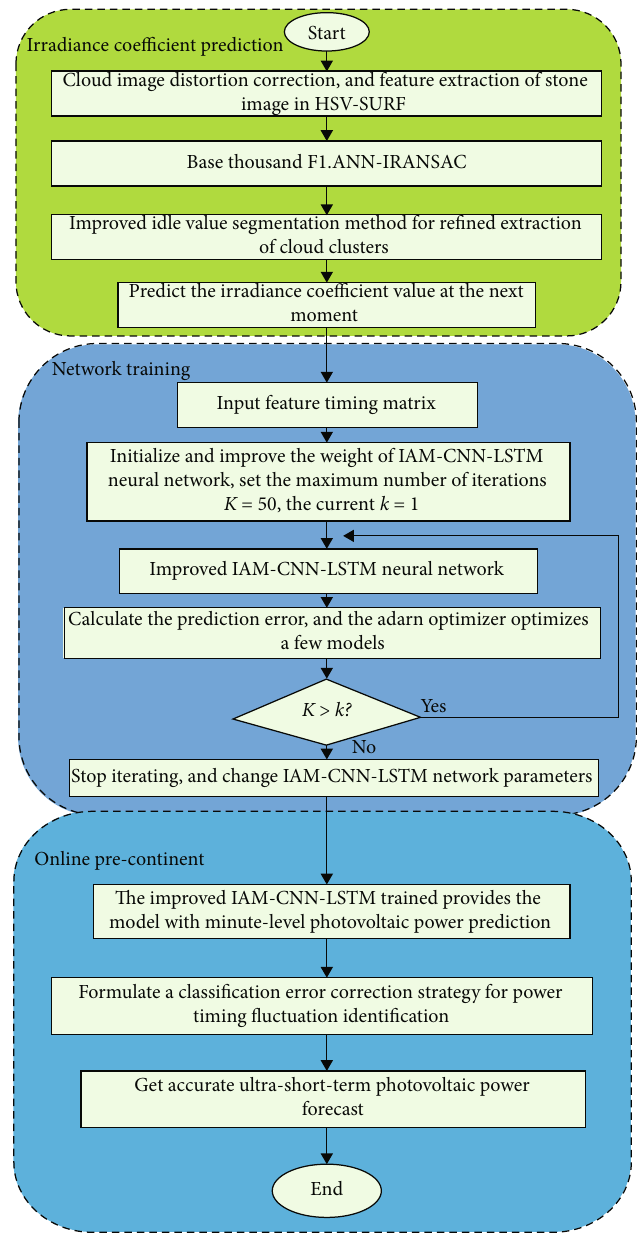
Figure 14: Flowchart of the proposed